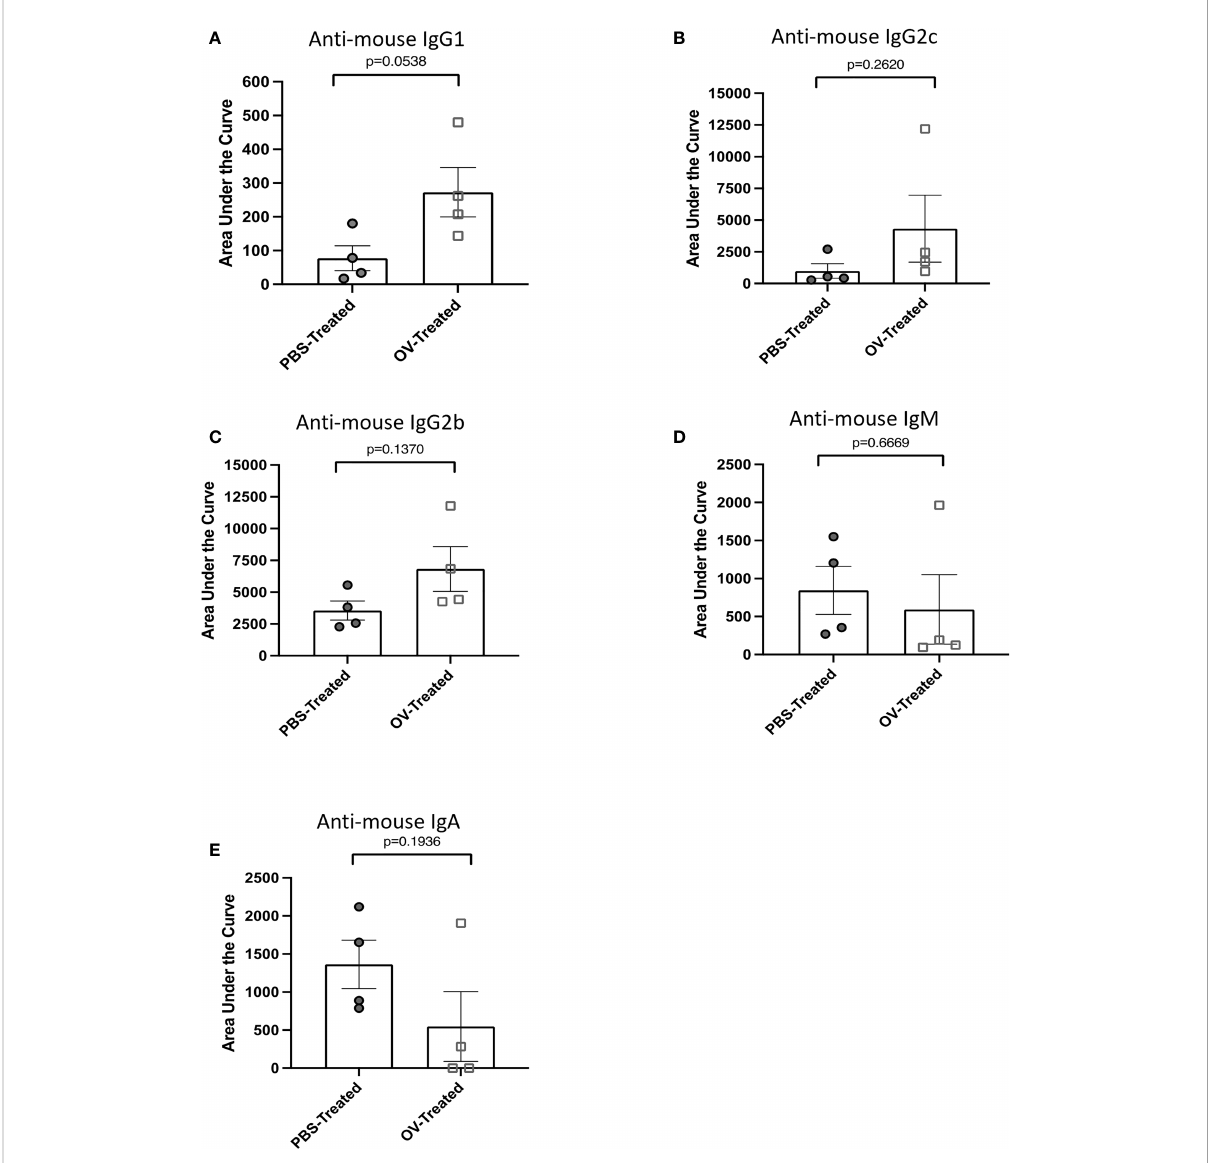
FIGURE 4 Multiplex assessment of tumor-associated antibody isotypes following oncolytic virotherapy. Tumor-associated antibody responses were quanti fi ed by fl ow cytometry on cell-free ascites fl uid collected from ID8 tumor-bearing mice 21 days following treatment with phosphate- buffered saline (PBS) or an oncolytic virus (OV) ( n =8 mice per group). Tumor-associated antibody binding was represented as a function of positive anti-mouse IgG1-APC, IgG2c-Alexa Fluor 488, IgG2b-PE-Cy7, IgM-PerCP-Cy5.5, or IgA-BV421-conjugated secondary antibody signals from target ID8 cells. Curves generated from the mean fl uorescence intensity of each positive secondary antibody signal from targeted ID8 cells treated with four-series dilution scheme of cell-free ascites fl uid samples were used to calculate the areas under the curves. The area under the curve was used to assess the tumor-associated antibody response of (A) IgG1, (B) IgG2c, (C) IgG2b, (D) IgM and (E) IgA isotypes within the cell- free ascites fl uid of PBS- or OV-treated mice. Statistical analysis was conducted using a two-tailed Student ’ s t-test. Statistical signi fi cance was de fi ned as P-values less than or equal to